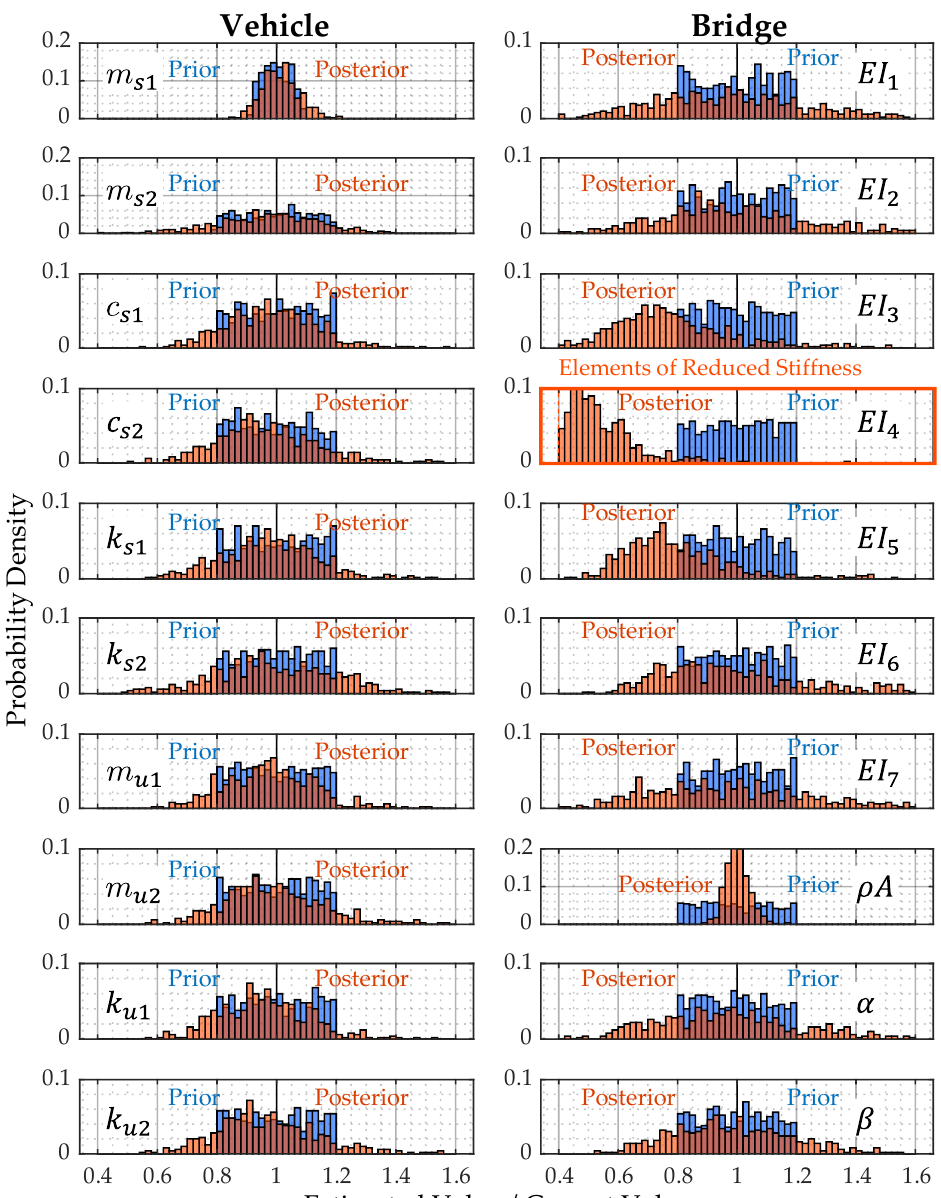
shown in this figure are calculated using the optimal particle 𝑿 𝑏𝑒𝑠𝑡(600) minimizing 𝐽 in Scenario 1.